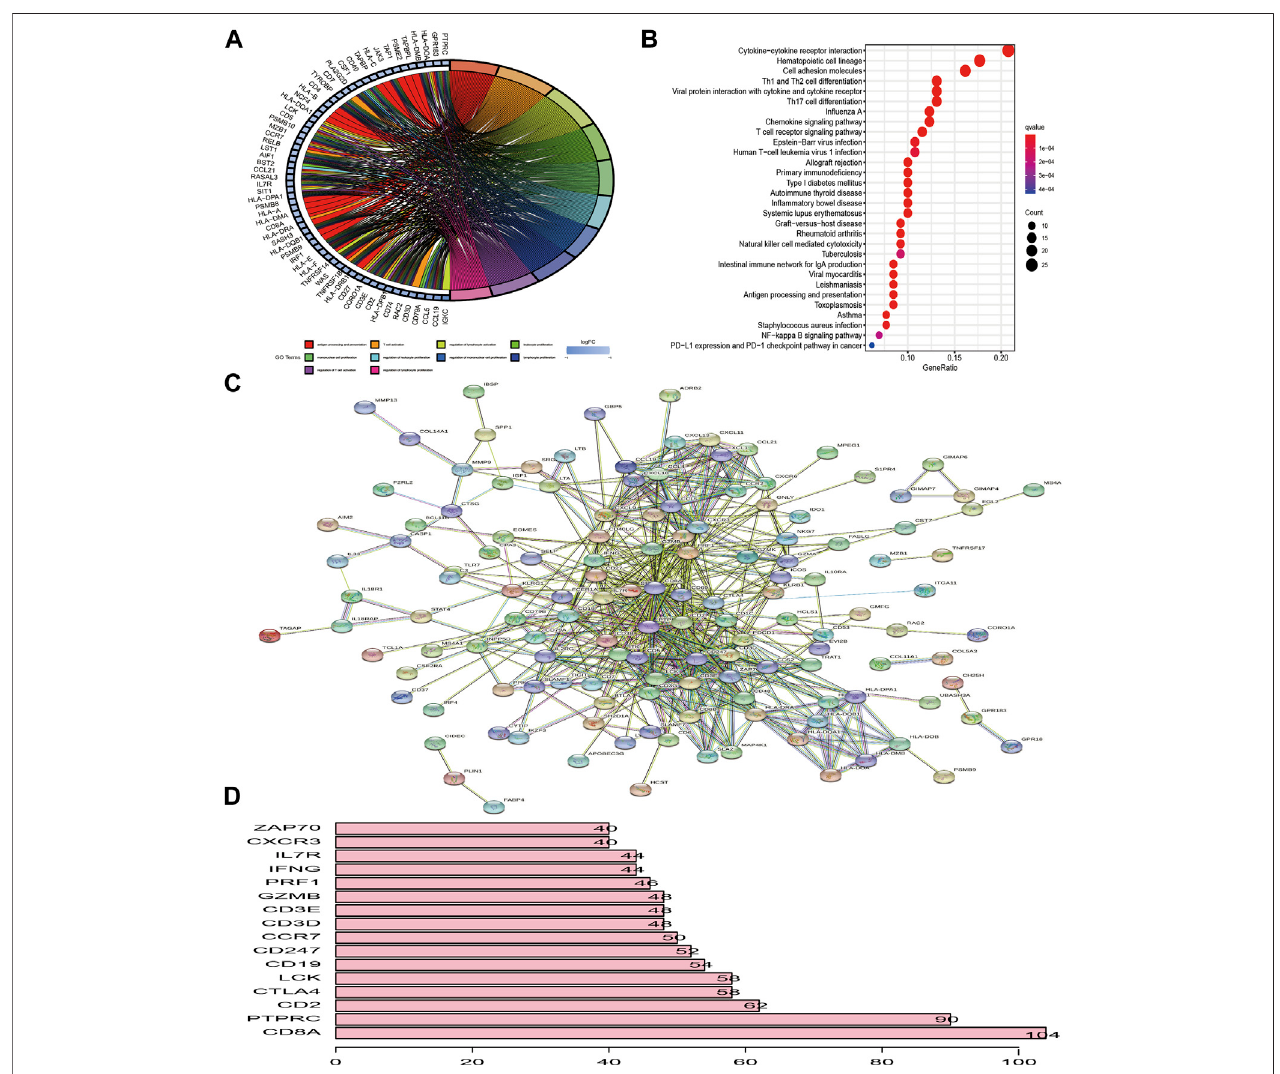
FIGURE 2 | Functional enrichment analysis of differentially expressed genes between distinct TME clusters. (A, B) GO and KEGG analysis of DEGs. (C) PPI of DEGs. The high con fi dence (0.700) was considered as the minimum required interaction score. (D) Identi fi cation of hub genes. Genes with degree of interaction more than 40 were recognized as hub genes. The X-axis label means the degree of interaction of each